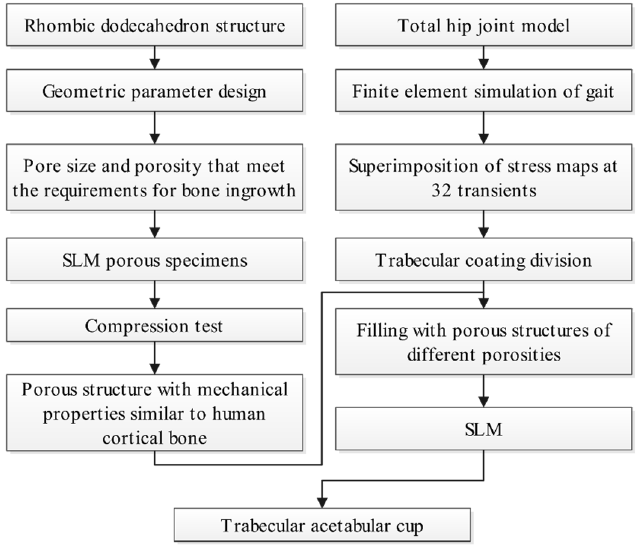
Figure 2. Flowchart of design and SLM fabrication of the trabecular acetabular cup.